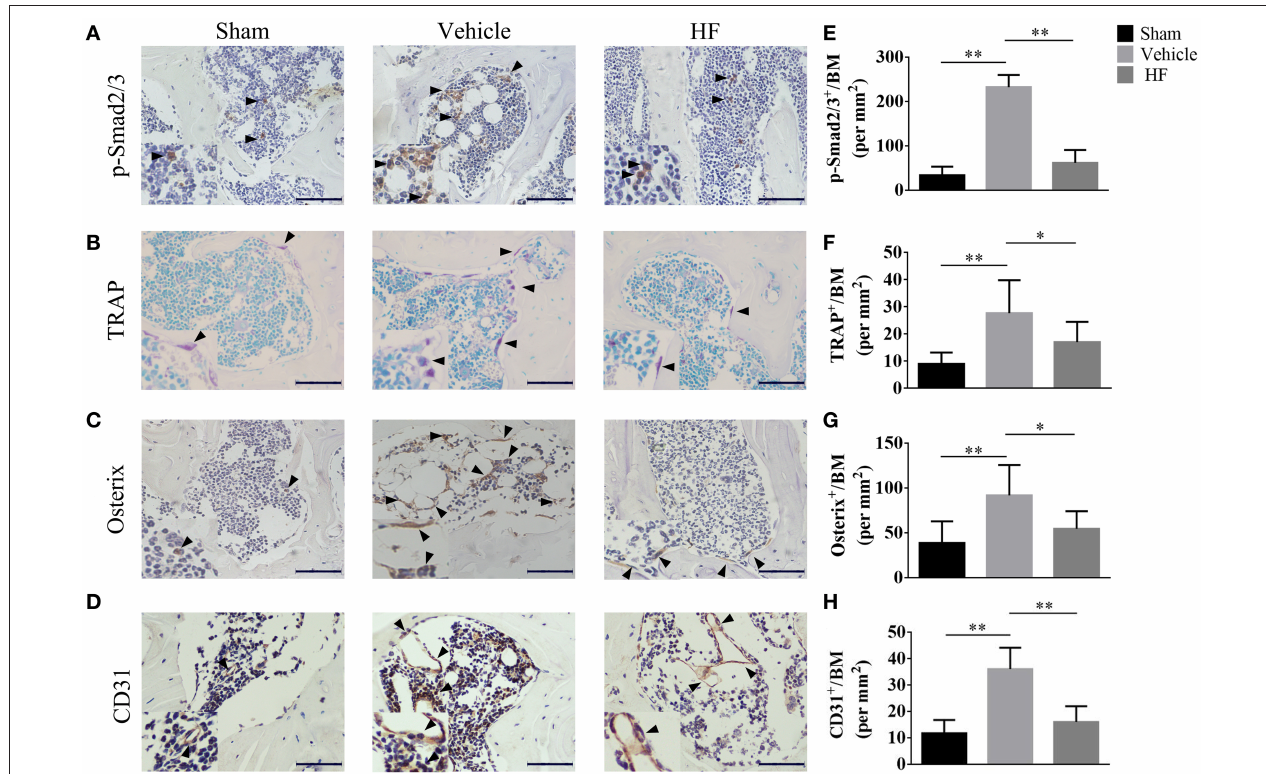
FIGURE 4 | HF coupled subchondral bone remodeling and inhibited aberrant angiogenesis. Immunostaining and quantitative analysis of number of p-Smad2/3 positive cell (A,E) , TRAP-positive osteoclasts (B,F) , Osterix-positive osteoblast progenitors (C,G) and CD31 positive cells (D,H) in tibial subchondral bone at 30 d after sham surgery or ACLT. 100 µ m. * p < 0.05 as denoted by bar, ** p < 0.01 as denoted by